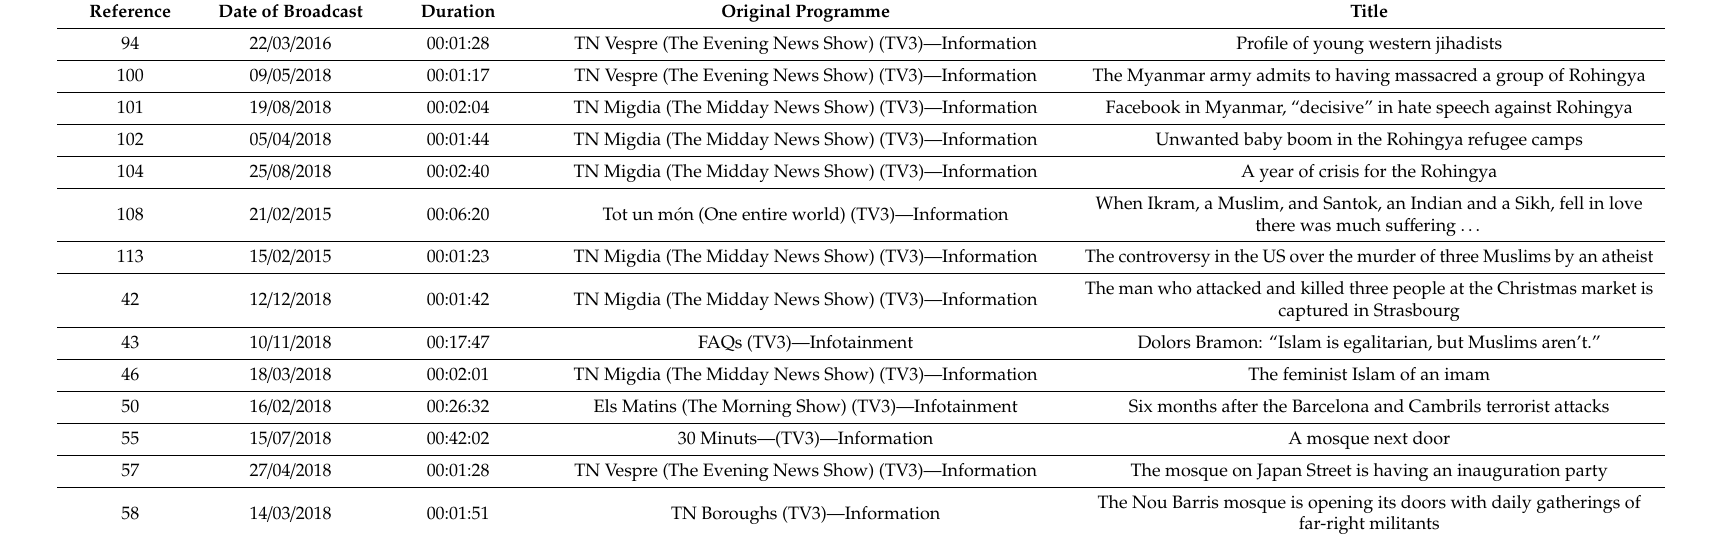
Table 2. Audio-visual material analysed where the perspective of the Muslim religion predominates.